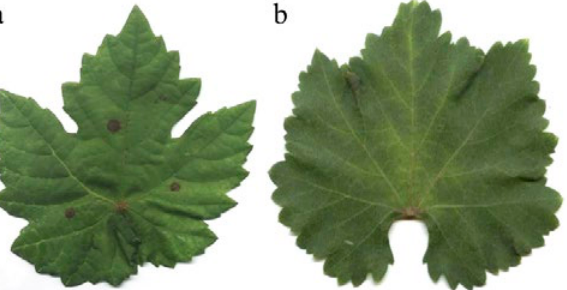
Figure 4. Necrotic areas produced by botryosphaerone D on a grapevine leaf cv. Inzolia (a); control leaf (b).